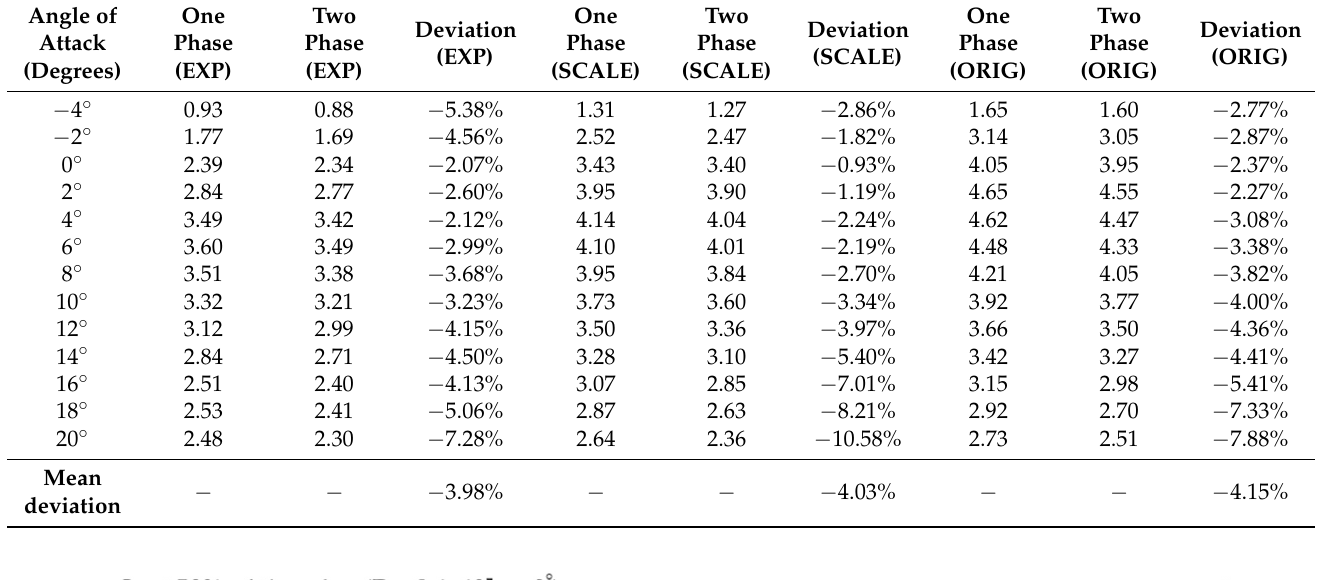
Table 1. L/D percentage degradation due to the existence of second phase, for the experimental wing model and the two simulation wing models.